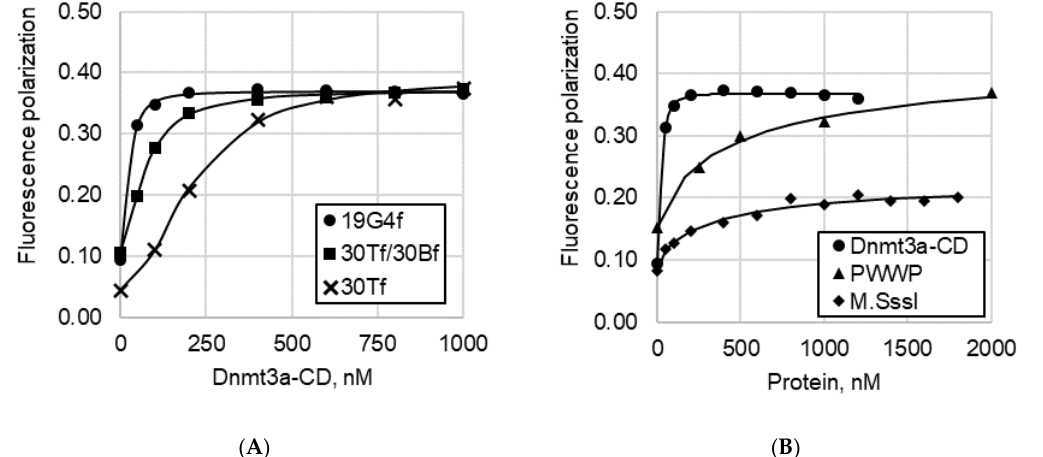
Figure 5. Curves of DNA binding to Dnmt3a domains and prokaryotic MTase M.SssI obtained from the fluorescence polarization assay data. ( A ) Dnmt3a-CD binding to FAM-labeled 19G4f, 30Tf, or 30Tf/30Bf. ( B ) 19G4f binding to Dnmt3a-CD, PWWP domain, or M.SssI. DNA probes (10 nM) were incubated with proteins in buffer A in the presence of 100 µM AdoHcy. Table 1. Dissociation constants ( K d ) of 19G4f, 30Tf or 30Tf/30Bf complexes with each protein under investigation.